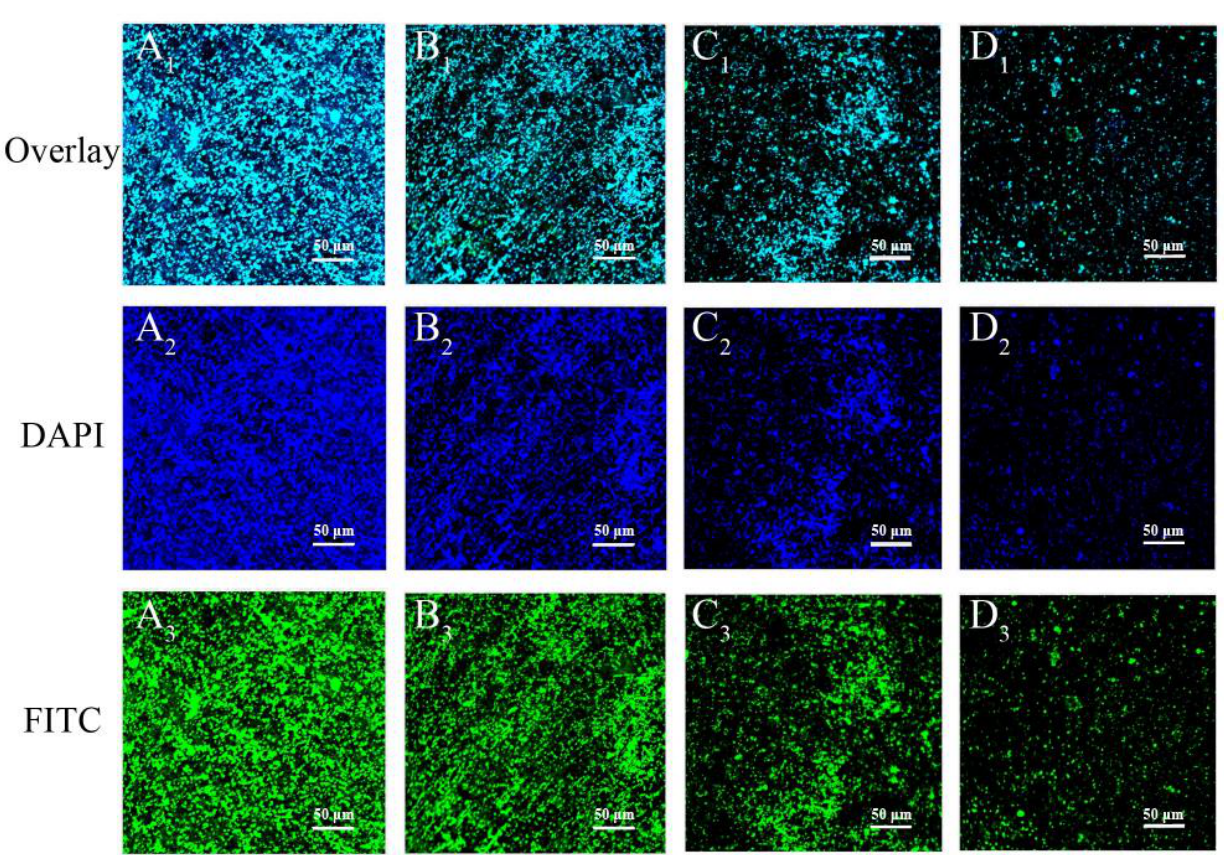
Figure 11. CLSM images at 40 × magnification of C. sakazakii biofilms treated with LC-EO at 0 MIC ( A 1 – A 3 ), 5 MIC ( B 1 – B 3 ), 10 MIC ( C 1 – C 3 ), 20 MIC ( D 1 – D 3 ).